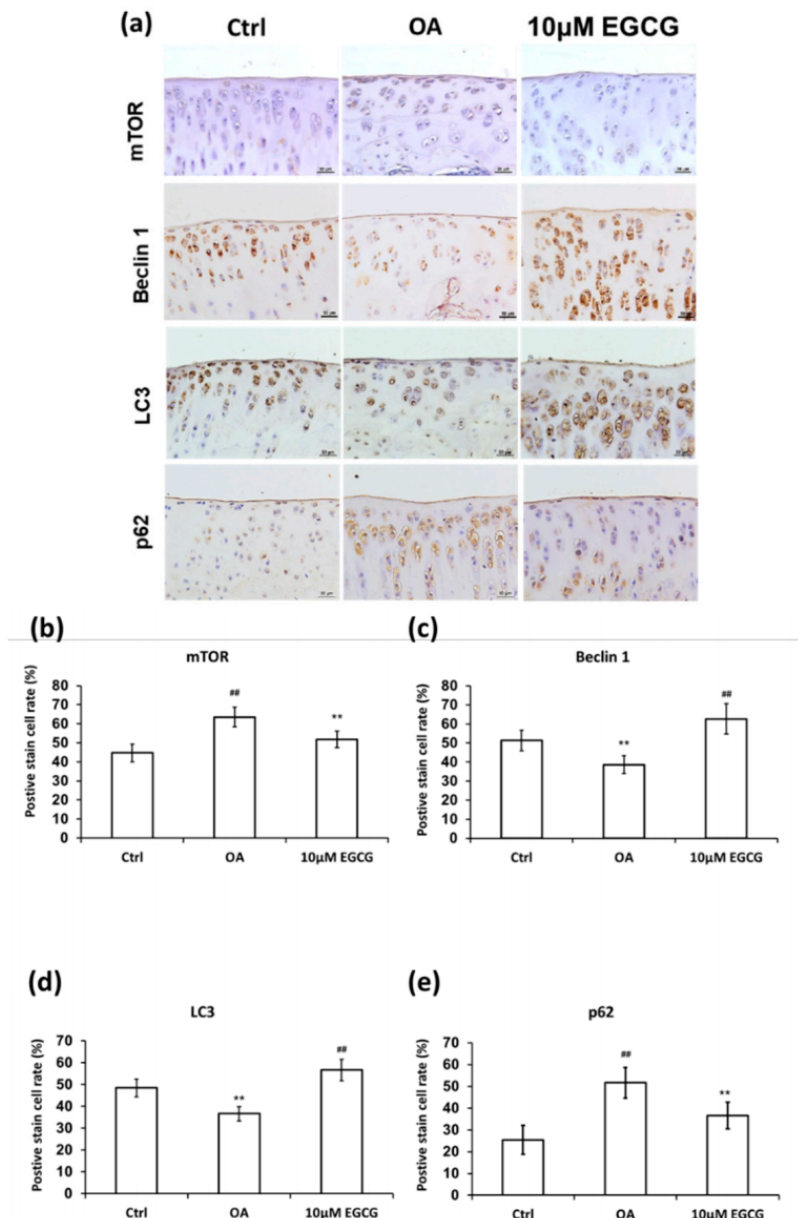
Figure 7. Immunohistochemistry (IHC) of autophagy-related proteins in articular cartilage of control, osteoarthritis (OA), and OA+EGCG joint. ( a ) The representative micrographs of the mechanistic target of rapamycin (mTOR)-, beclin-1-, light chain 3 (LC3)-, and p62-immunostained articular cartilages from the joints of control, osteoarthritis (OA), and OA+EGCG groups. The positive stained cell ratio of autophagy-related proteins were measured and compared among groups. The results of mTOR were shown in ( b ), beclin-1 were shown in ( c ), LC3 were shown in ( d ), and p62 were shown in ( e ) (** p < 0.01 OA vs. control; ## p < 0.01 OA vs.